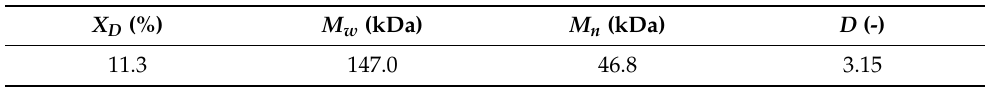
Table 1. Molar percentage of D-units ( X D ), mass-average molar mass ( M w ), number-average molar mass ( M n ), and polydispersity ( D ) of PLA used in the present work. X D (%) M w (kDa) M n (kDa) D